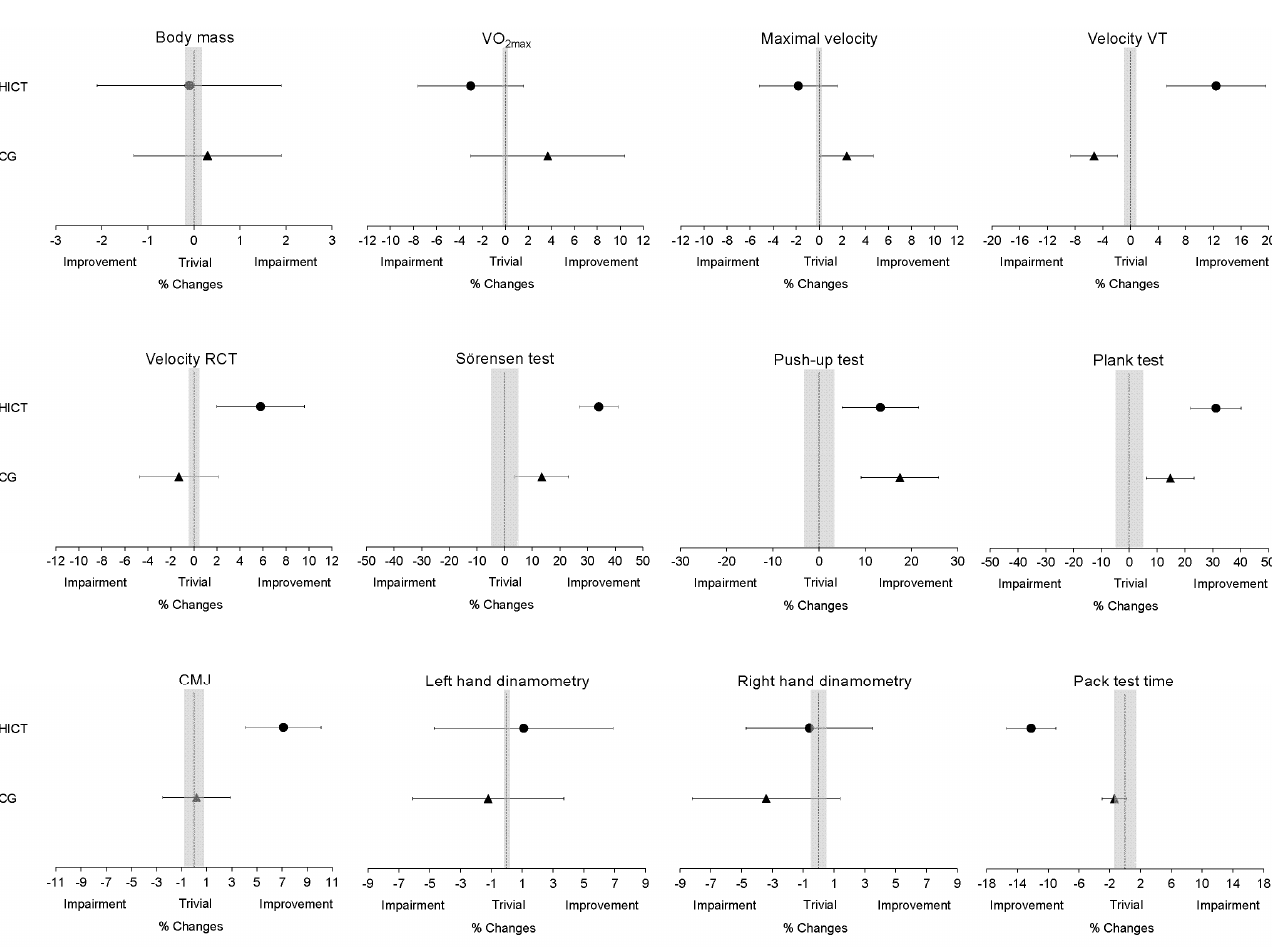
and control group (CG). Values are mean ± 90% confidence interval. Trivial areas were computed from the meaningful changes.